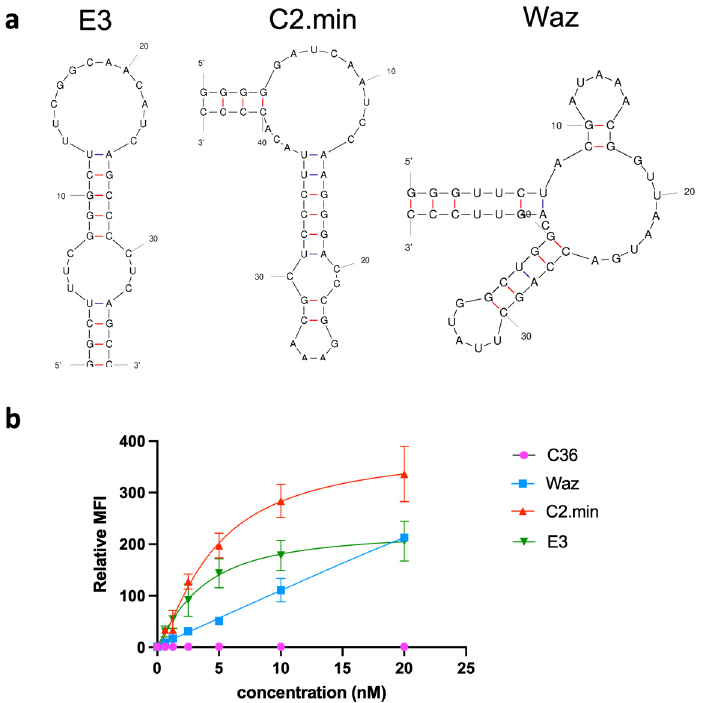
Figure 1. Aptamer structures and their binding on immobilized recombinant human transferrin receptor. ( a ) Predicted secondary structures of E3, C2.min, and Waz based on their sequences. Structures were generated by mFold. ( b ) A plot of median fluorescence measured via flow cytometry. Fixed amounts of immobilized hTfR were incubated with increasing concentrations of DL650-E3, DL650-C36, DL650-Waz, or DL650-C2.min. For 1 h before washing. MFI = median fluorescent intensity and signals were normalized to signals collected from the bead-TfR sample.